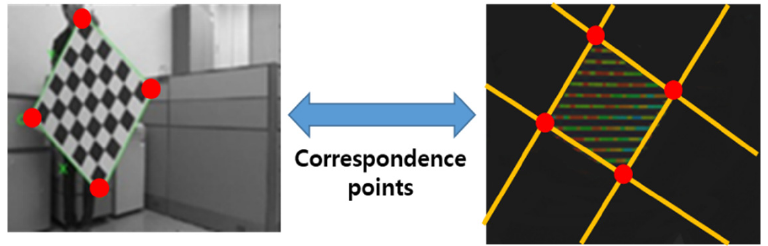
Figure 13. Four-correspondence for calibration.